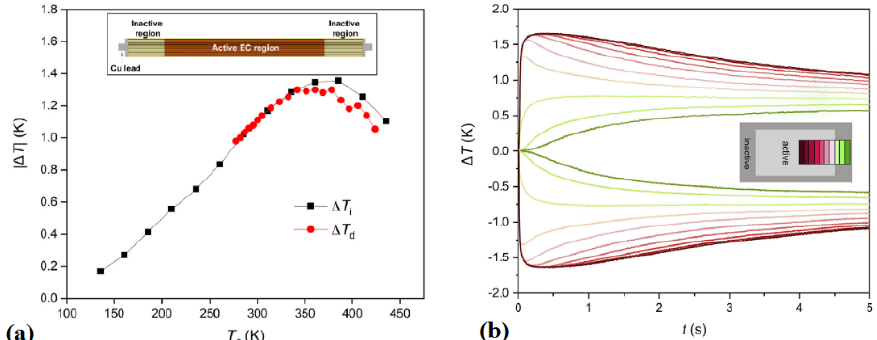
Figure 12. ( a ) Experimental and numerical comparison under ∆ E = 130 kV cm − 1 . ( b ) Temperature profile across the electrocaloric system under ∆ E = 210 kV cm − 1 , up to reaching steady state with a starting temperature of 298 K [70].